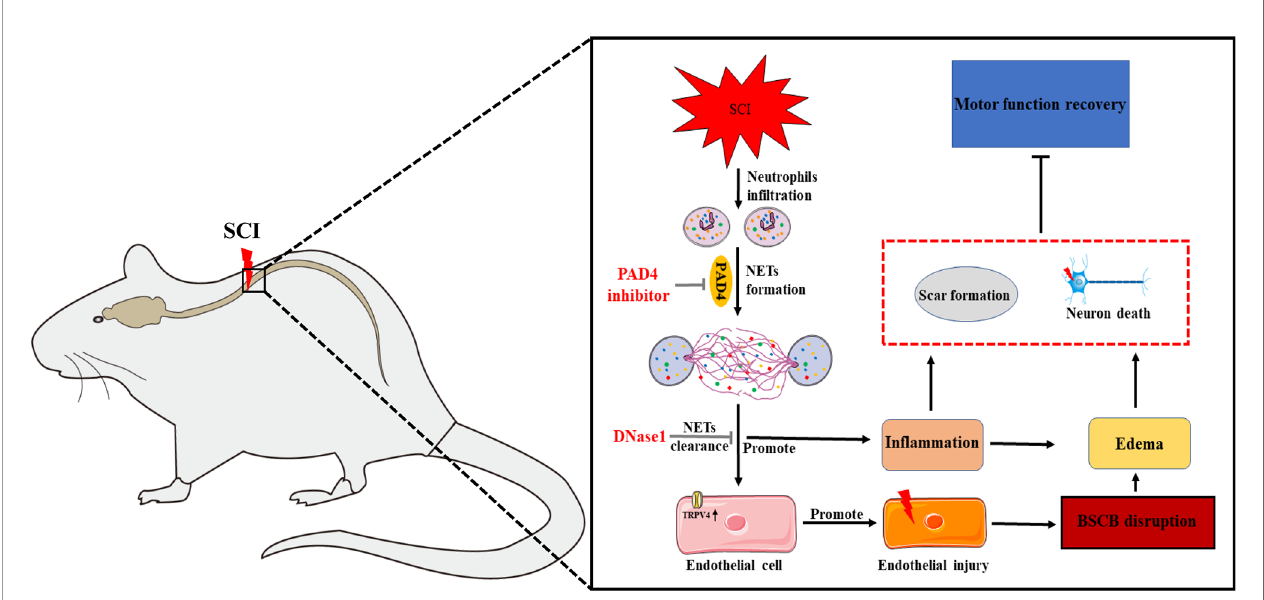
FIGURE 10 | Mechanism of neutrophil extracellular traps (NETs) exacerbates secondary injury after spinal cord injury. In fi ltrated neutrophils produce NETs, which subsequently promote neuroin fl ammation and blood – spinal cord barrier disruption to aggravate spinal cord edema and neuronal apoptosis partly via elevating transient receptor potential vanilloid type 4 (TRPV4) level following SCI in rats. Both inhibition of NETs formation by peptidylarginine deiminase 4 (PAD4) inhibitor and disruption of NETs by DNase 1 alleviate secondary damage and promote functional recovery after